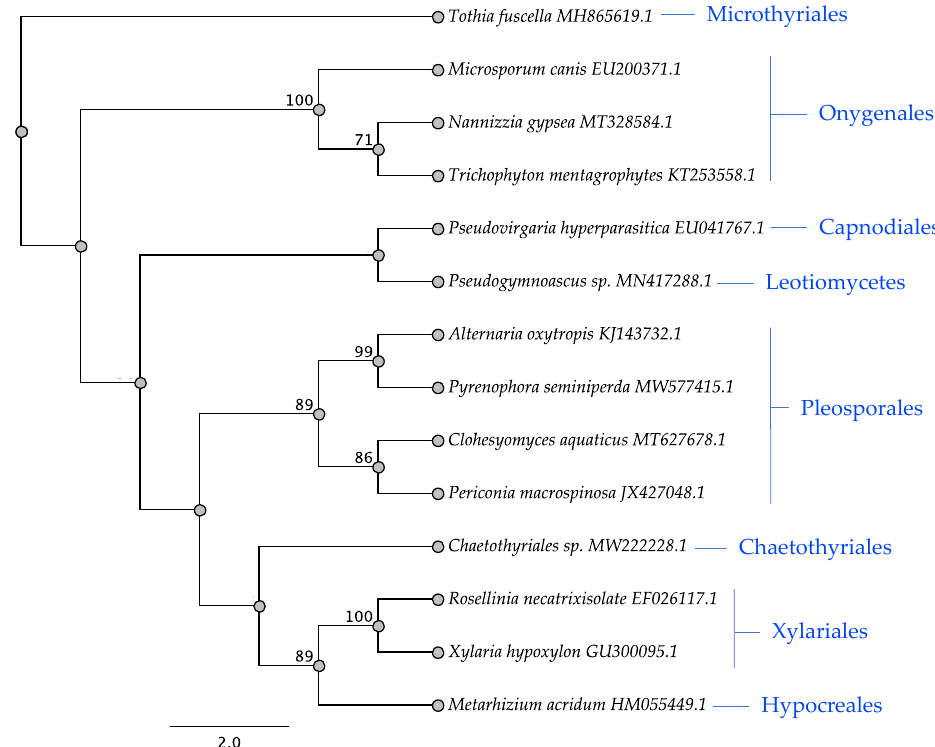
Figure 15. DNA tree resulting from the analysis of the Internal Transcribed Spacer ITS sequence data. Bootstrap confidence values from 1000 bootstrap replicates are presented at each corresponding node. Tothia fuscella was used as the outgroup. Fungal orders are indicated next to each organism/clade.